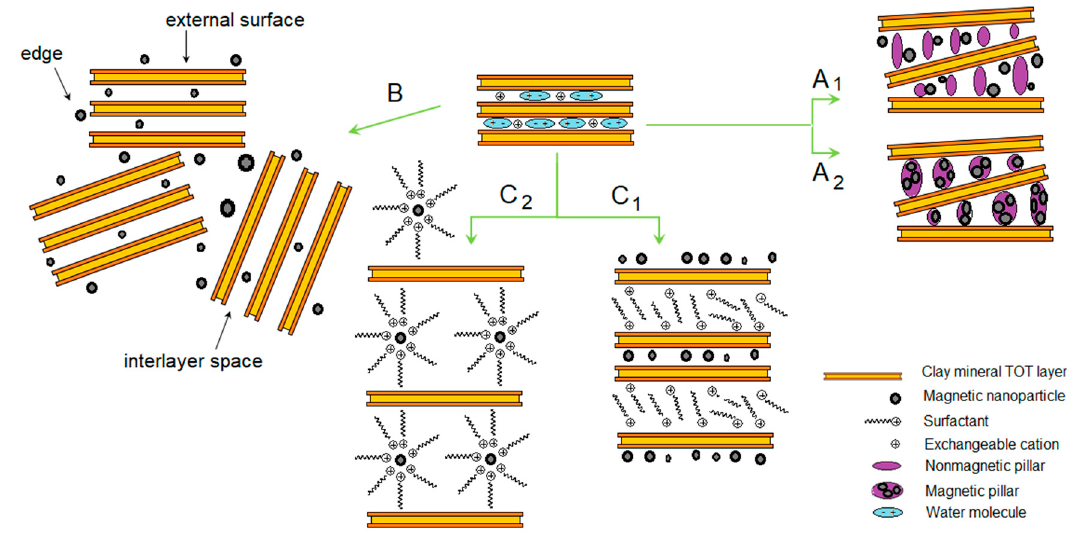
Figure 2. Scheme of typical synthesis routes to obtain magnetic nanoparticle / clay mineral 2:1 type (MNP / CM) nanocomposites: (A1) pillaring with nonmagnetic pillar; (A2) pillaring with magnetic pillar; (B) coprecipitation; (C1) intercalation of MNP into surfactant intercalated clay mineral; (C2) intercalation of surfactant-modified MNP into clay mineral.